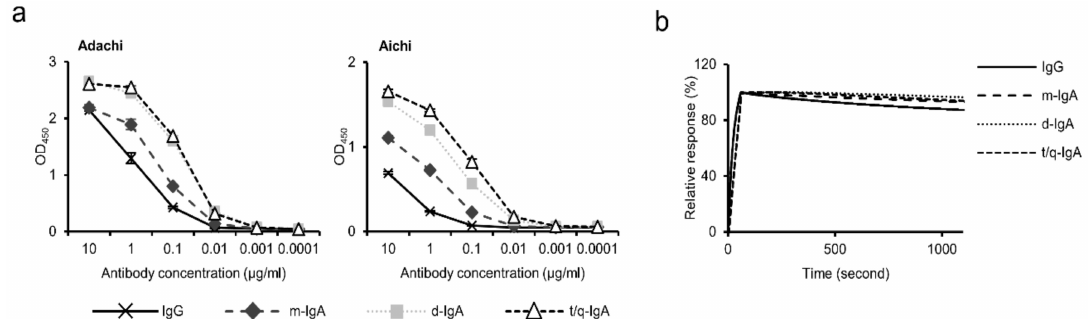
Figure 2. Comparison of binding to M2 antigens among the ch-rM2ss23 antibodies. Reactivities of IgG, m-IgA, d-IgA, and t / q-IgA (0.0001–10 µ g / mL) to recombinant M2 proteins of A / Adachi / 2 / 1957 (H2N2) (Adachi) and A / Aichi / 2 / 1968 (H3N2) (Aichi) were measured in enzyme-linked immunosorbent assay (ELISA) ( a ). Binding dynamics of ch-rM2ss23 IgG, m-IgA, d-IgA, and t / q-IgA to the synthetic N-terminal extracellular domain of Aichi M2 peptide ( b ). Sensorgrams were adjusted (x = 0, y = 0: baseline, y = 100: binding) to allow comparisons between di ff erent antibody forms in terms of the dissociation rate.